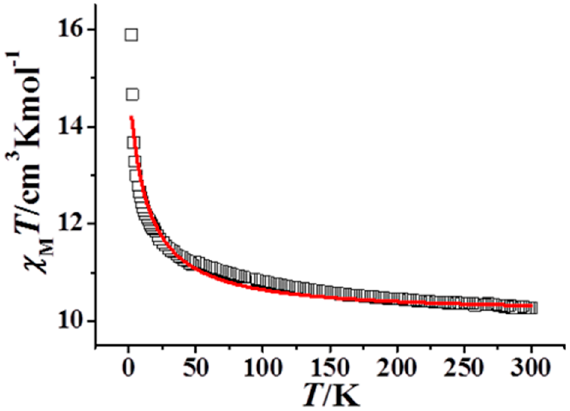
Figure 4. χ M T vs. T plots for complex 2 . The red line is the best fit.